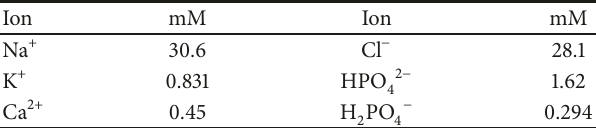
Table 1: Inorganic ions concentration in